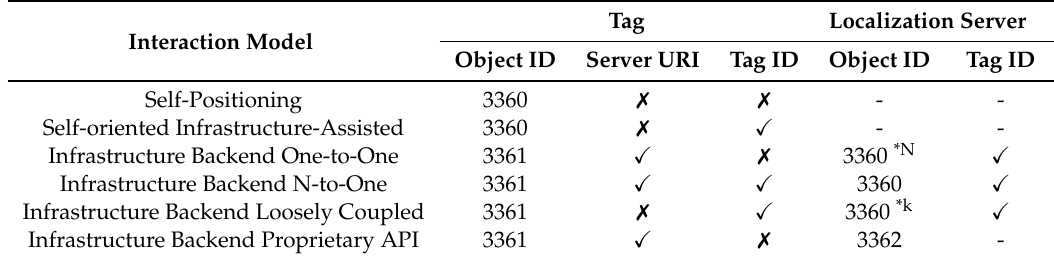
Table 6. LwM2M objects and resources exposed for each interaction